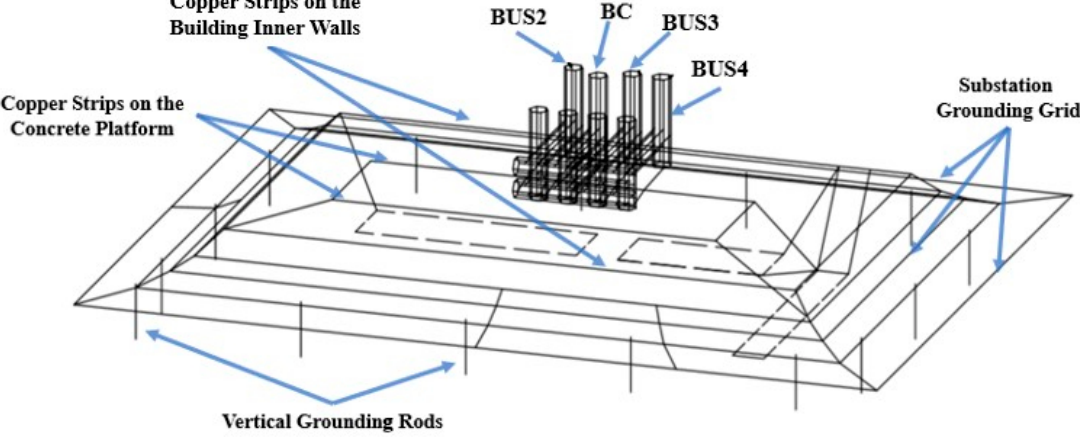
Figure 5. CAD representation of analysis stage 2: GIS model with four bus sections’ modules.